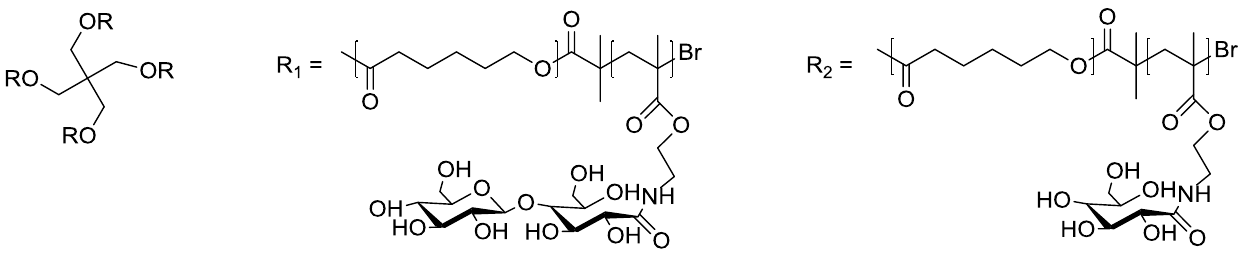
Figure 11. Biomimetic block copolymers based on poly(ε-caprolactone):